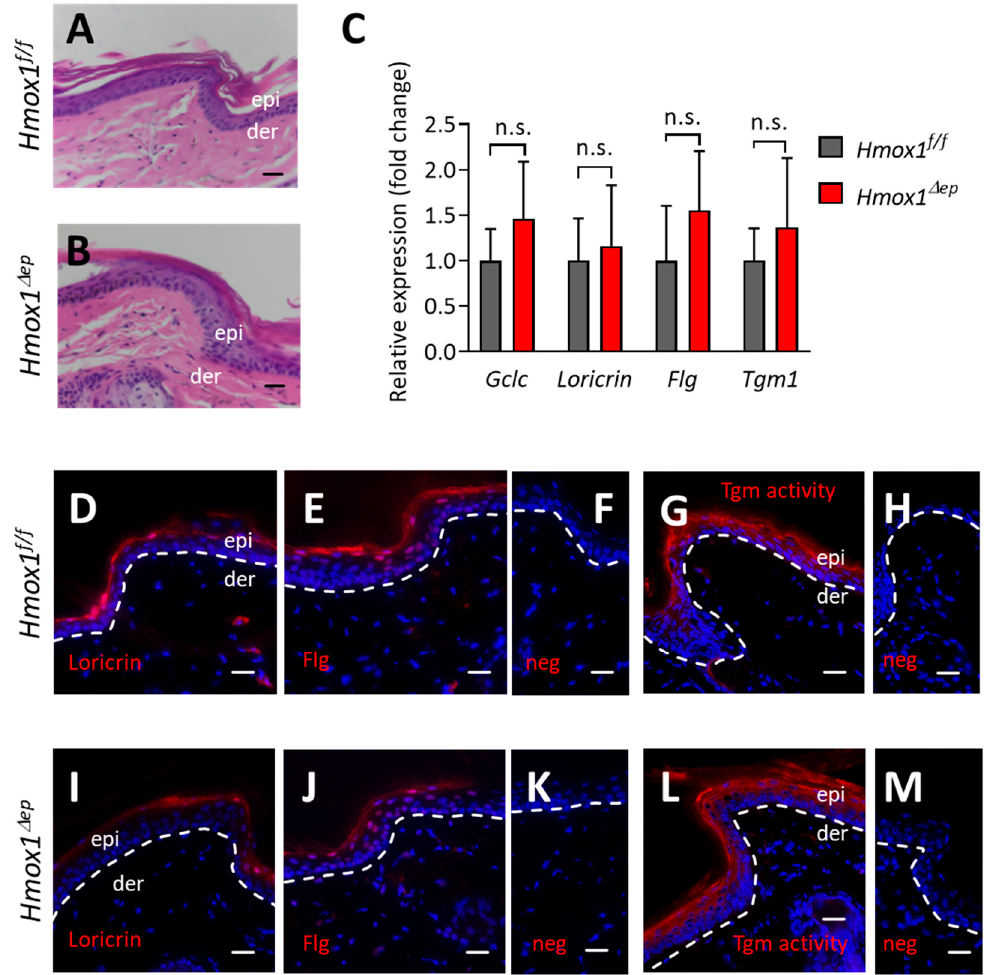
Figure 5. Epithelial deletion of heme oxygenase-1 ( Hmox1 ) does not impair cornification. Sections through the tail skin of Hmox1 f/f ( A , D – H ) and Hmox1 Δ ep ( B , I – M ) mice at an age of 4–6 months were stained with hematoxylin and eosin ( A , B ), immunofluorescence-labelled (red) for loricrin ( D , I ), filaggrin ( E , J ) and labelled (red) for transglutaminase (Tgm) activity ( G , L ). In negative (neg) control experiments, the primary antibody was replaced by immunoglobulin from non-immunized animals ( F , K ) and calcium was replaced by EDTA ( H , M ). Sections were counter-stained with hematoxylin (blue) ( A , B ) and Hoechst 33258 (blue) ( D – M ). Images are representative for n = 3 mice per genotype. The dermo–epidermal junction is marked with a dashed-in line ( D – M ). Scale bars, 20 µm. ( C ) The mRNA levels of glutamate-cysteine ligase catalytic subunit ( Gclc ), loricrin , filaggrin ( Flg ) and transglutaminase 1 ( Tgm1 ) in the skin of Hmox1 f/f (grey bars, n = 6) and Hmox1 Δ ep (red bars, n = 7) mice were quantified by RT-PCR and normalized to B2m . n.s., not significant ( t -test).